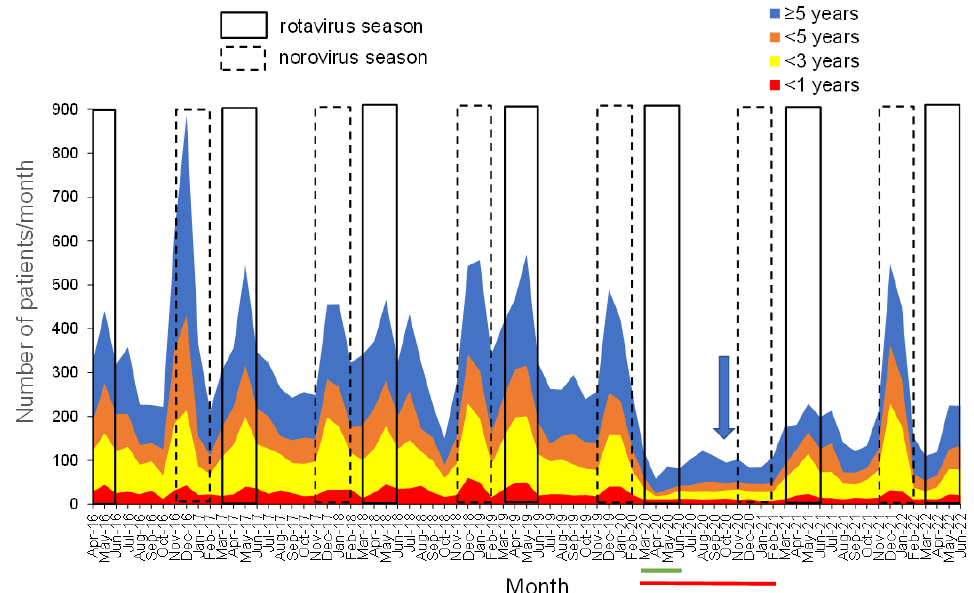
Figure 1. Monthly changes in the number of patients with AGE stratified into <1 year, 1 to <3 years, 3 to <5 years, and ≥ 5 years. The figure shows the monthly changes in the number of patients with AGE (<1-year-old (red); 1–<3-year-old (yellow); 3–<5-year-old (orange); and ≥ 5-year-old (blue)). The vertical axis indicates the number of patients with AGE. The horizontal axis indicates calendar months. The blue arrow indicates the date of the implementation of universal RVV. The green bar under the graph indicates the period of the state of emergency. The red bar under the graph indicates the period of the COVID-19 era. AGE, acute gastroenteritis.